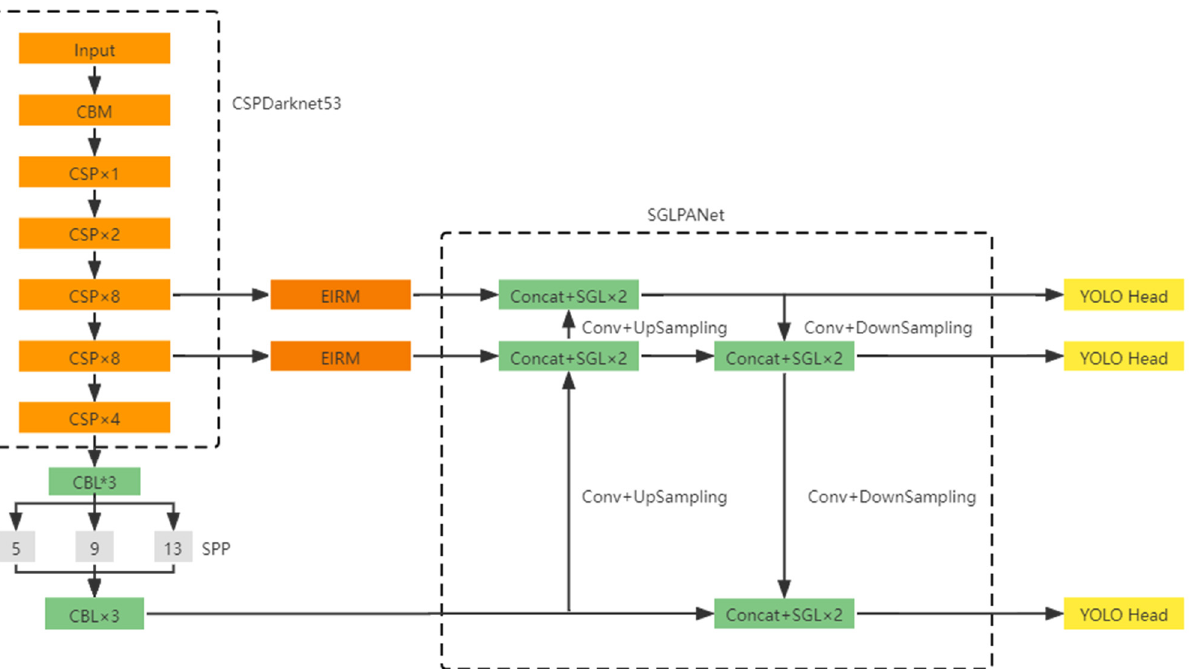
Figure 1. The overall structure of the proposed method. SGL stands for SandGlass-L block.